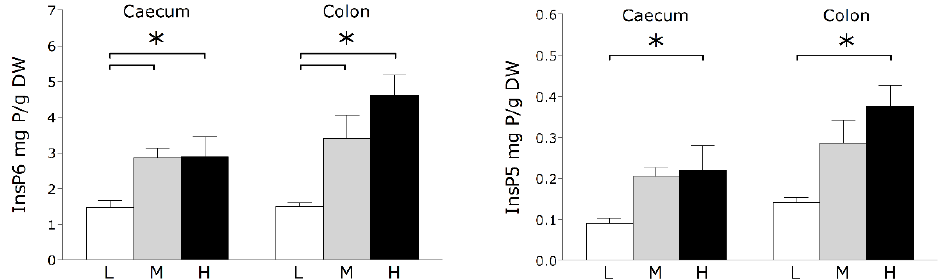
Figure 1. Levels of inositol hexakisphosphate (InsP6) and inositol pentakisphosphate (InsP5) in the caecum and colon of piglets fed a varying supply of mineral P for a period of 5 weeks. Significant differences are indicated by an asterisk (*; p < 0.05). L, M, H—dietary groups receiving lower, medium, and higher mineral P levels; DW—dry weight.